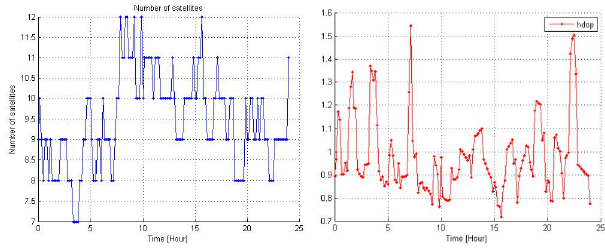
Figure 4: Number of visible satellites (left) and HDOP (right) during a day.